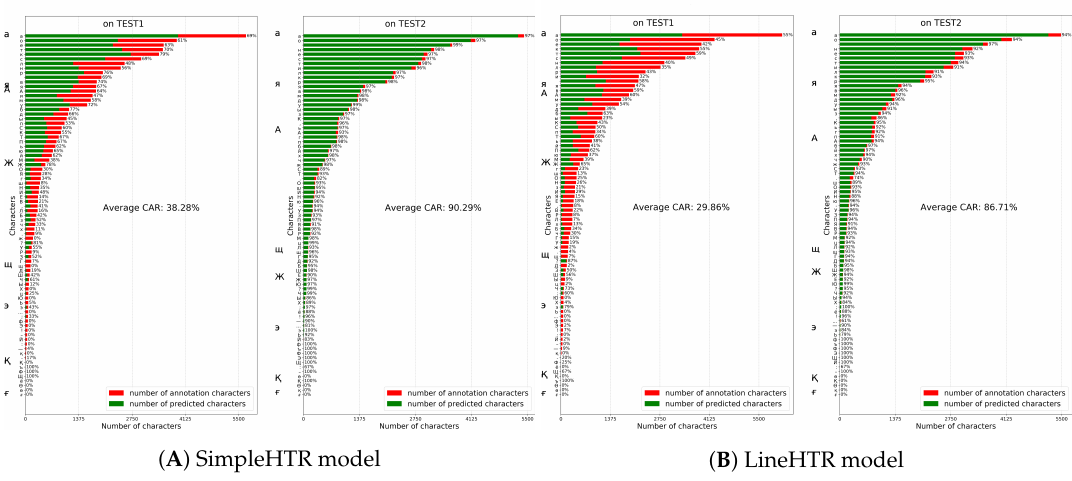
Figure 9. SimpleHTR and LineHTR models performance on TEST1 and TEST2